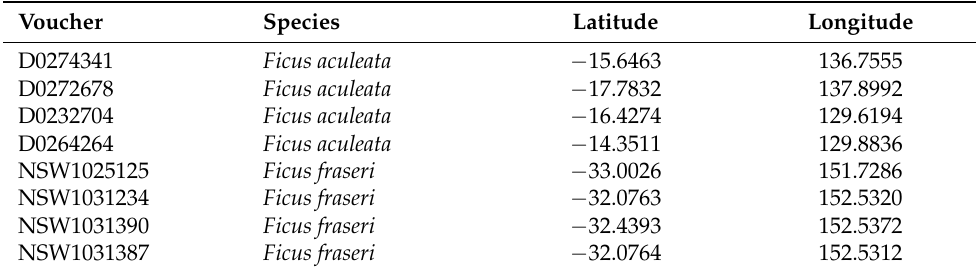
Figure A2. Principal component analysis showing Ficus coronata (Red) 178 individuals, and the 2 sandpaper species that can co-occur, Ficus aculeata (Blue)-4 individuals and Ficus fraseri (Orange)-4 individuals. No evidence was found for hybridisation within the study specimens. Table A1. Individuals of Ficus aculeata and Ficus fraseri used in this study.